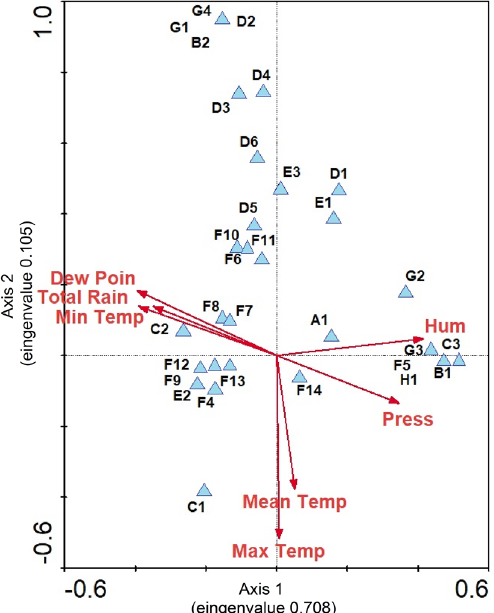
Figure 2. Ordering diagram generated by CCA (Axis 1 Eigenvalue = 0.708, Axis 2 Eigenvalue = 0.105) showing all mosquito species and climatic variables gathered during May, July, October, and December 2018 and April, July, September, and November 2019, near the Jirau hydroelectric plant in Rondônia state, Brazil. Only maximum temperature was found significant (p-value = 0.0406) after 5000 Monte Carlo permutations. A1: Aedeomyia squamipennis; B1: Aedes fulvithorax; B2: Aedes scapularis; C1: Anopheles argyritarsis; C2: Anopheles evansae; C3: Anopheles triannulatus; D1: Coquillettidia albicosta; D2: Coquillettidia albifera; D3: Coquillettidia chrysonotum; D4: Coquillettidia fasciolata; D5: Coquillettidia juxtamansonia; D6: Coquillettidia venezuelensis; E1: Culex bastagarius; E2: Culex melanonconion; E3: Culex mollis ; F4: Mansonia amazonensis; F5: Mansonia dyari; F6: Mansonia flaveola; F7: Mansonia fonsecai ; F8: Mansonia humeralis; F9: Mansonia iguassuensis ; F10: Mansonia indubitans ; F11: Mansonia pessoai; F12: Mansonia pseudotitillans ; F13: Mansonia titillans ; F14: Mansonia wilsoni; G1: Psorophora albipes; G2: Psorophora cingulata ; G3: Psorophora dimidiata; G4: Psorophora ferox; H1: Uranotaenia pulcherrima.